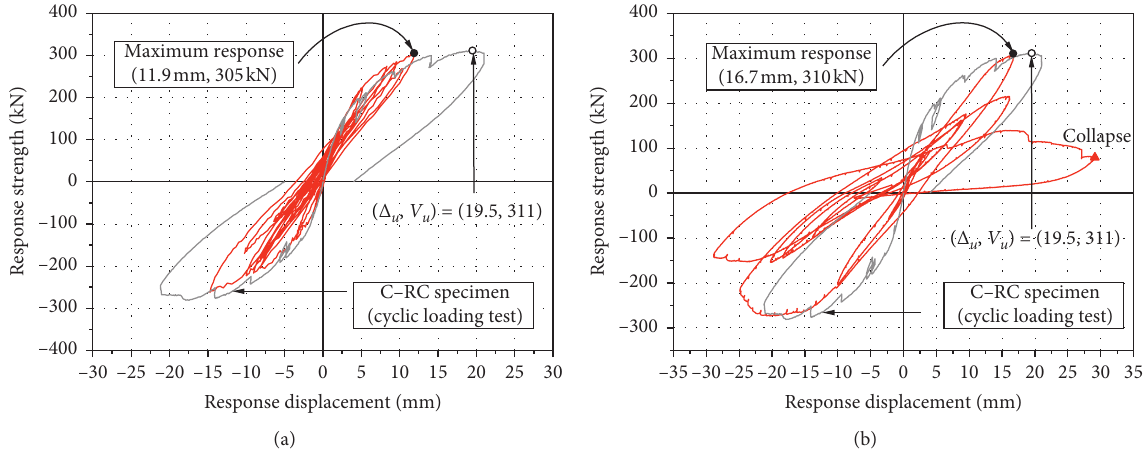
Figure 11: Lateral response load-displacement relationships for the control PD-RC specimen during pseudodynamic testing at (a) 250gal and (b) 300gal.